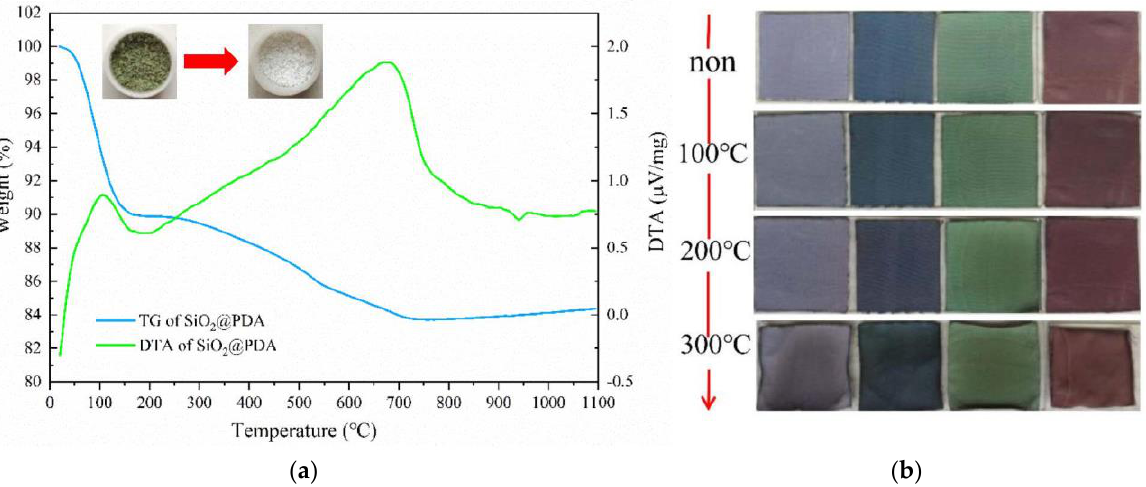
Figure 7. ( a ) TG-DTA measurements of the SiO 2 @PDA powder in an N 2 atmosphere. ( b )Thermal stability of SiO 2 @PDA photonic crystals with diameters of 198, 234, 271, and 360